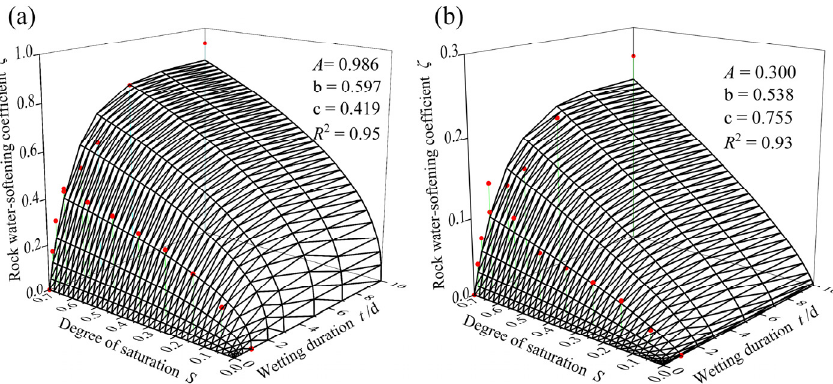
Figure 4. Fitting results of shear strength parameters of carbonaceous mudstone: ( a ) cohesion; ( b ) angle of internal